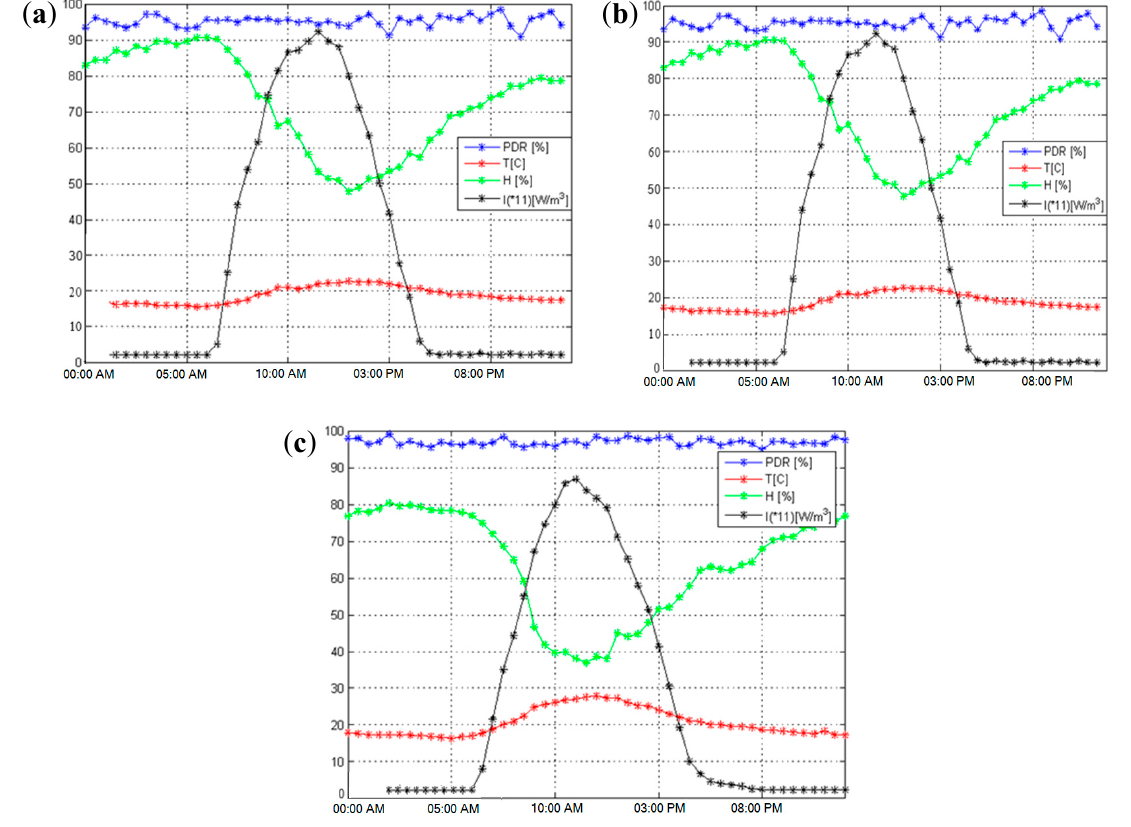
Figure 3. Behavior of FSO link vs weather factors during ( a ) December 2014, ( b ) January 2015 and ( c ) February 2015 (winter season).